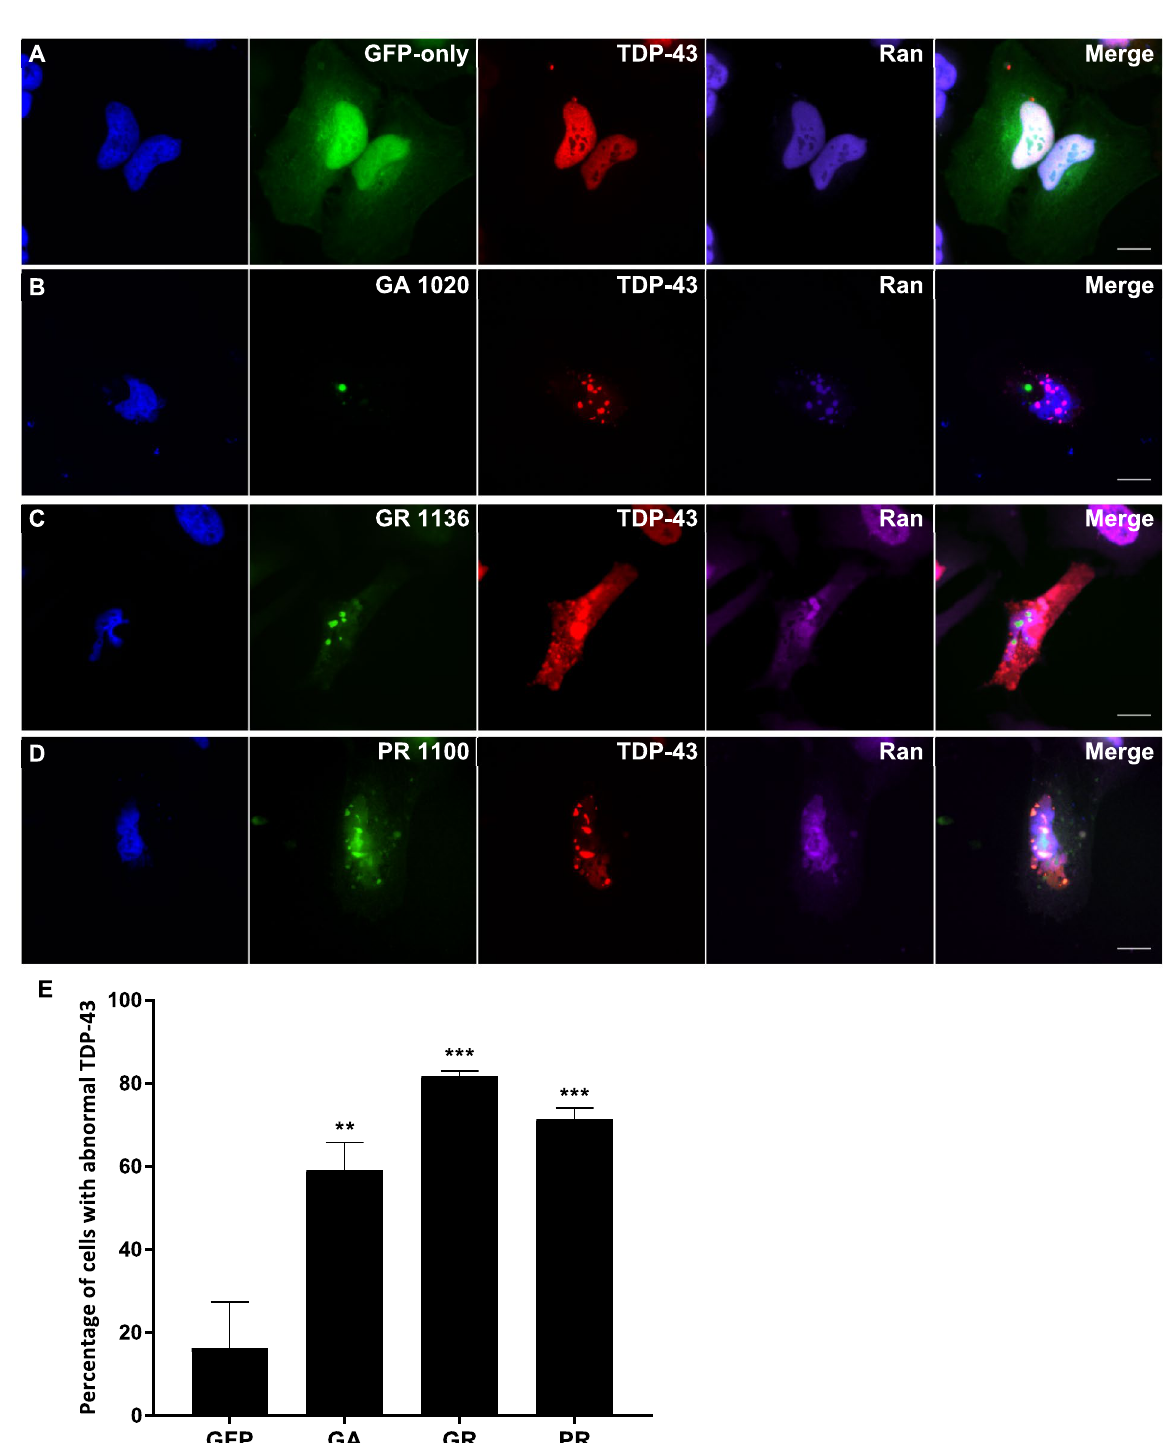
Figure 4. DPRs caused TDP-43 mislocalisation to the cytoplasm. ( A – D ) HeLa cells co-transfected with mCherry-tagged human TDP-43 (red) and GFP-tagged DPR constructs or empty pEGFP-N1 vector as a GFP-only control were fixed and stained 48h post-transfection. TDP-43 was frequently mislocalised to the cytoplasm in cells containing GA, GR or PR inclusions. Many DPR-expressing cells also exhibited some TDP-43 aggregation. Scale bars indicate 15 μm. ( E ) Graph shows the mean percentage of total TDP-43 fluorescence signal which was localised to the cytoplasm. The proportion of TDP-43 in the cytoplasm was significantly increased by expression of GA 1020 ( P = 0.0003), GR 1136 ( P < 0.0011), and PR 1100 ( P = 0.0349) but not AP 1024 ( P = 0.9999). n = 3, with a minimum of 30 cells analysed for each independent replicate. Data was analysed by one-way ANOVA with Dunnett’s multiple comparison test. Error bars indicate